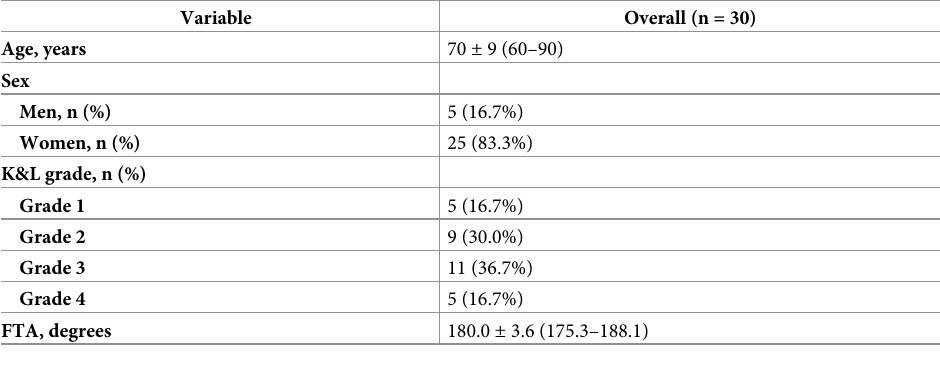
Table 1. Baseline characteristics of patients with knee